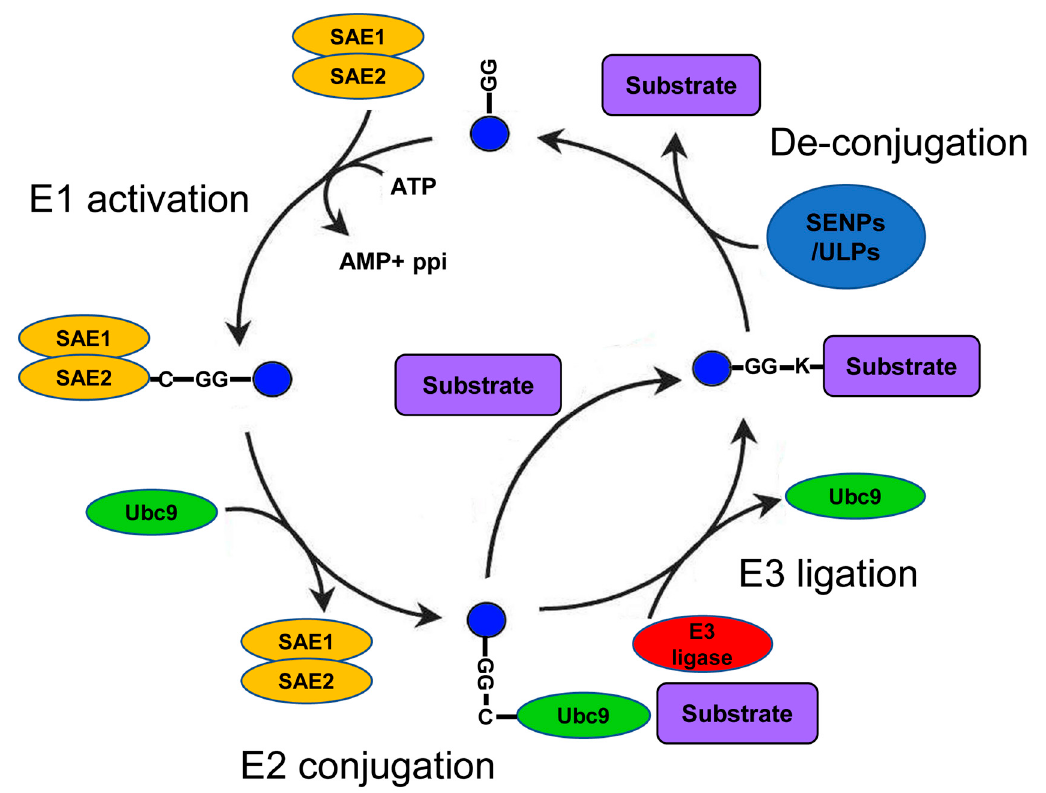
Figure 1. The Small Ubiquitin-like Modifier (SUMO) conjugation cycle: The names of the enzymes are based on mammalian nomenclature. After SUMO cleavage (not shown), SUMO is conjugated to a heterodimeric E1 ligase complex (SAE1/2). Next, SUMO is transferred to the E2 ligase (Ubc9). Finally, the SUMO-Ubc9 molecule forms a complex with an E3 ligase (e.g., PISA1–4) and with the target protein. This complex formation facilitates the transfer of SUMO to a specific lysine residue on the sequence of the target protein. Alternatively, SUMO conjugation to the E2 ligase, Ubc9, can be followed by the direct transfer of SUMO to the protein target independently of E3 ligase activity. Substrates can be conjugated with a single SUMO (monoSUMOylation), with multiple SUMO peptides on different lysine residues (multiSUMOylation), or with a chain of SUMO2/3 tags (polySUMOylation). SUMO-specific proteases (named SENtrin-specific Proteases (SENPs) in mammals and Ubiquitin-Like Proteases (ULPs) in nonmammalian organisms cleave SUMO from its protein substrate in order to reverse SUMO conjugation and activity.